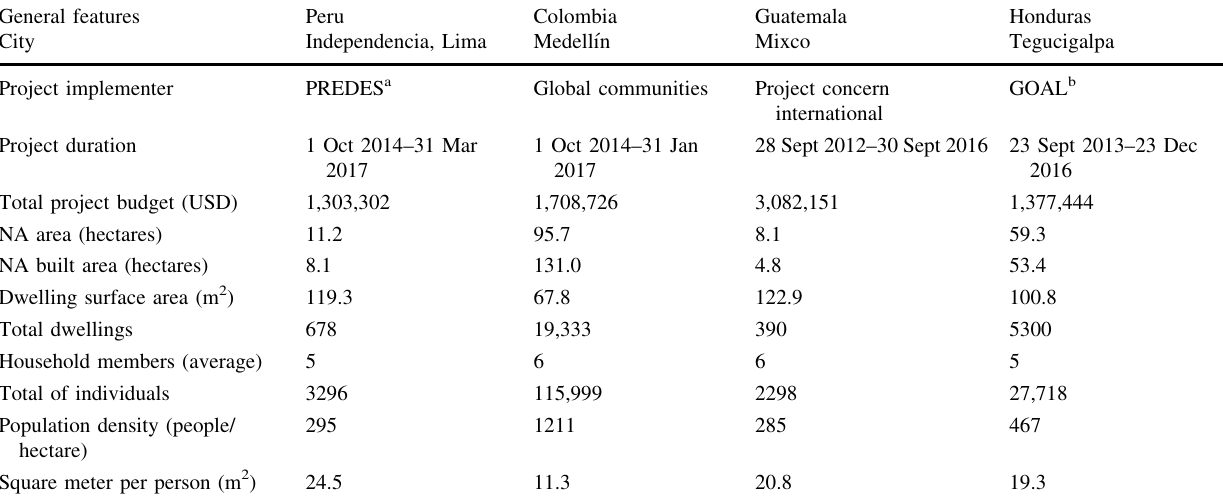
Table 1 Neighborhood Approach – Disaster Risk Reduction (NA-DRR) Projects in select Latin American cities—general features General features